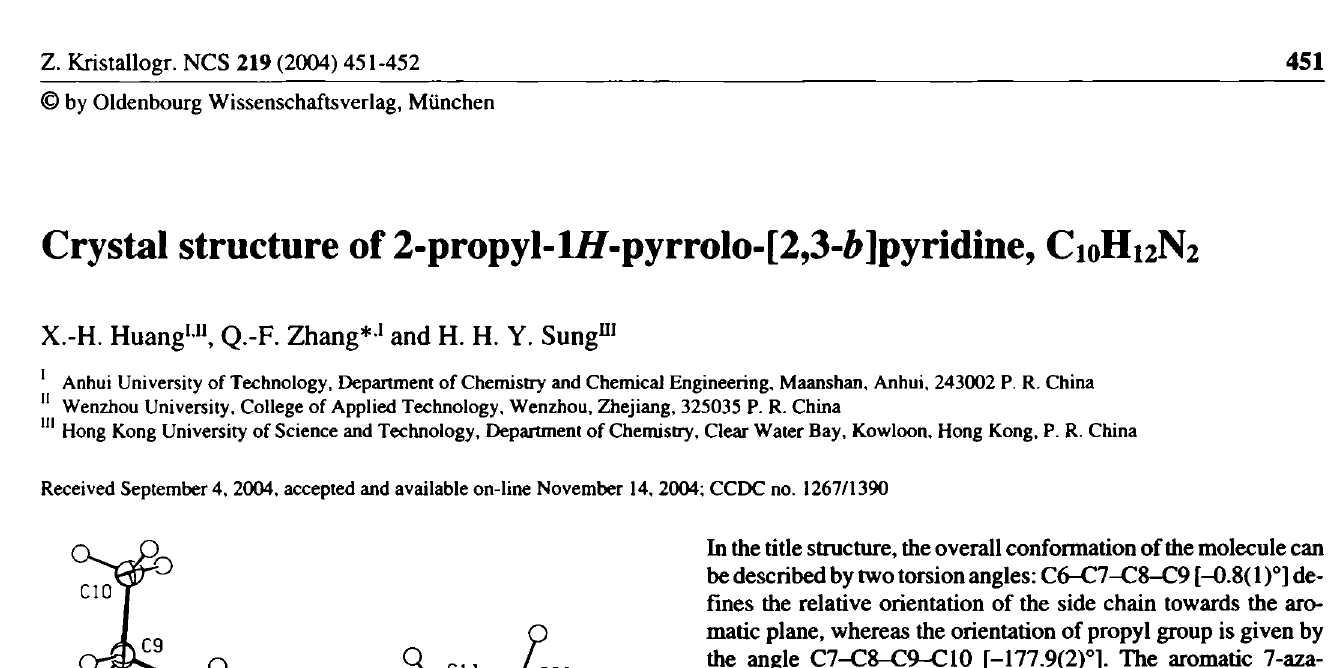
Table 1. Data collection and handling.